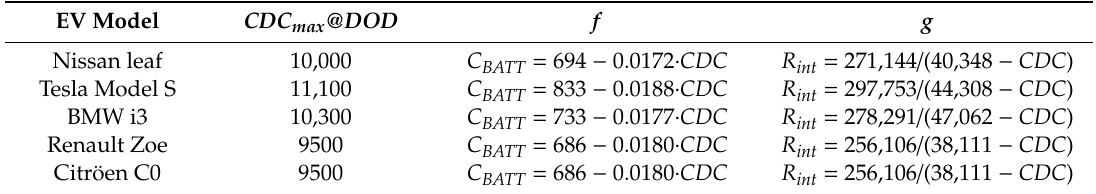
Table 11. C BATT and R int aging approximation—CSs with shared II-Life